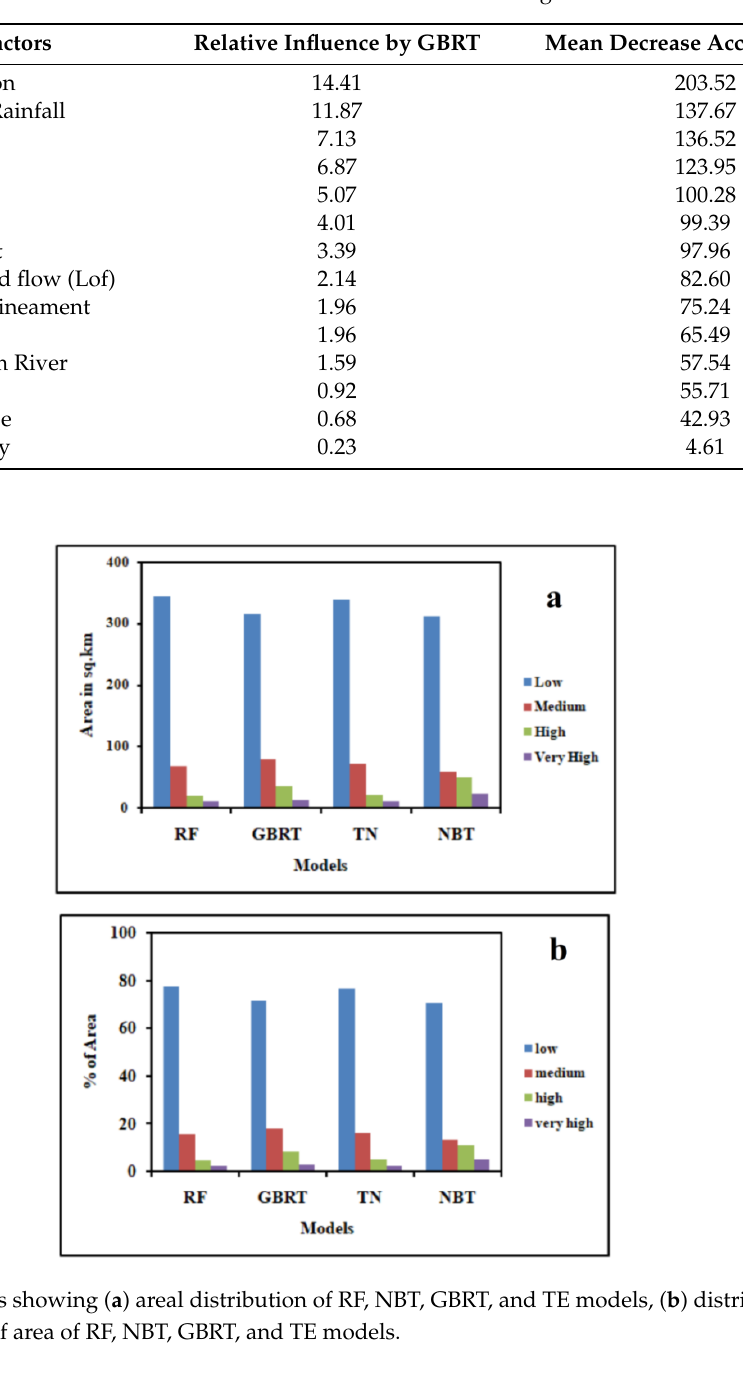
Table 5. Relative influence of e ff ective conditioning factors.